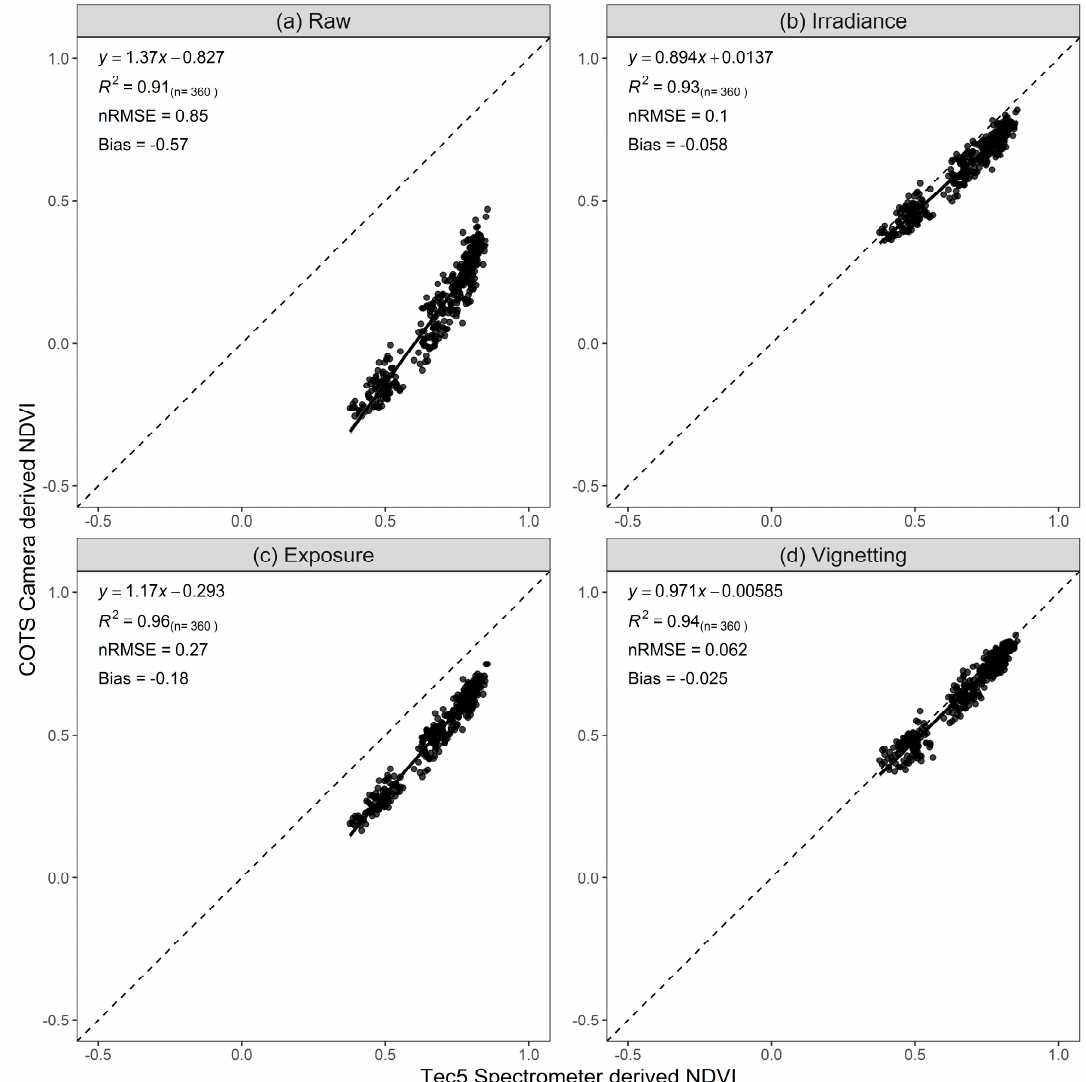
Figure 9. Assessment of the cumulative influence of radiometric corrections applied to COTS camera-derived NDVI. Results for ( a ) Raw, ( b ) Irradiance, ( c ) Exposure and ( d ) Vignetting corrected NDVI are compared to scaled COTS camera convolved Tec5 measurements of mean plot NDVI. Dashed line indicates the 1:1 line.